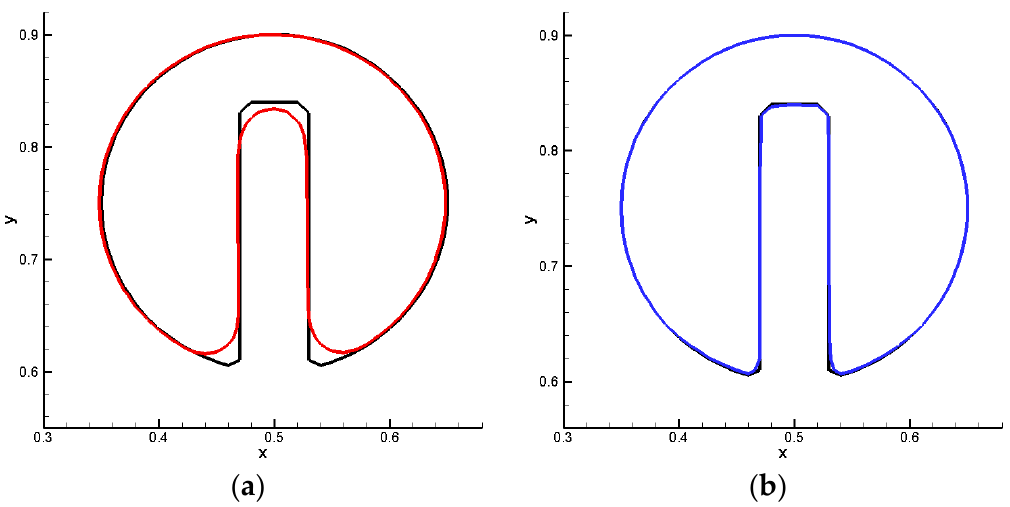
Figure 1. Comparison of the level set solution (red), particle level set solution (blue), and theory (black) after one revolution of rigid body rotation of Zalesak’s disk in a constant vorticity velocity field (more information about Zalesak’s disk can be found in [20]): ( a ) level set method; and ( b ) particle level set method.